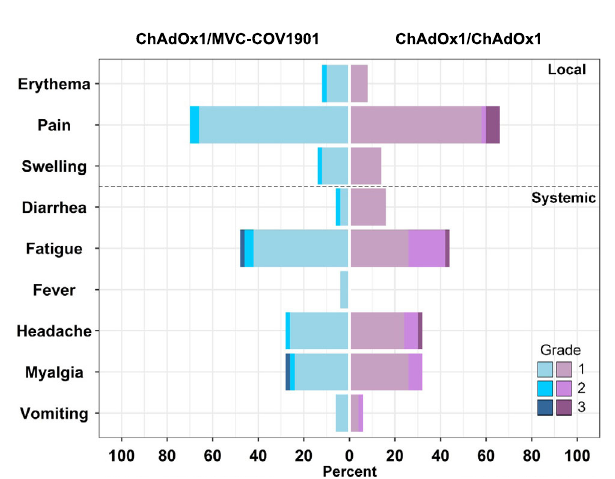
Fig. 2 | Solicited local and systemic adverse events in the 7 days after the booster dose of the heterologous ChAdOx1/MVC-COV1901 ( n =50) and homologousChAdOx1/ChAdOx1( n =50)group. Grades1,2and3adverseevents were marked in light blue, blue and deep blue for the ChAdOx1/MVC-COV1901 group. Grades 1, 2 and 3 adverse events were marked in light purple, purple and deep purple for the ChAdOx1/ChAdOx1 group. The higher the grade, the more severe the adverse event. Source data are provided as a Source Data fi